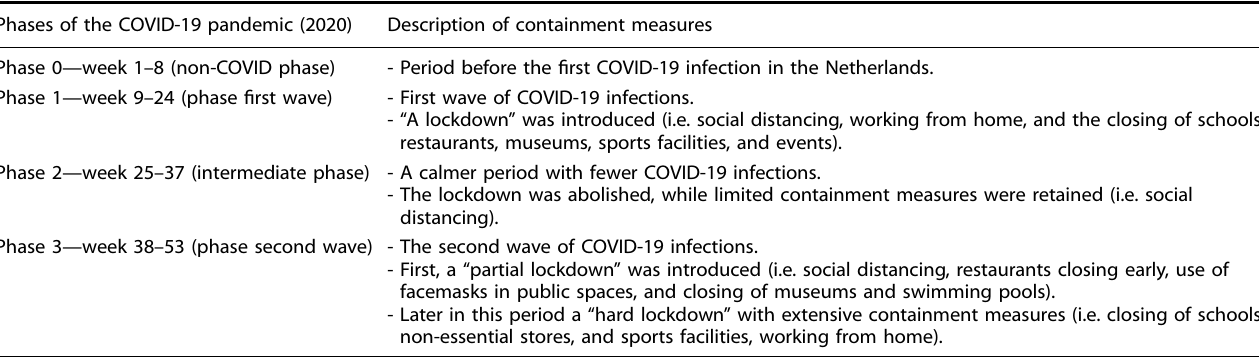
Table 5. Phases of the COVID-19 pandemic in terms of the containment measures and waves of COVID-19 infections in the Netherlands. Phases of the COVID-19 pandemic (2020) Description of containment